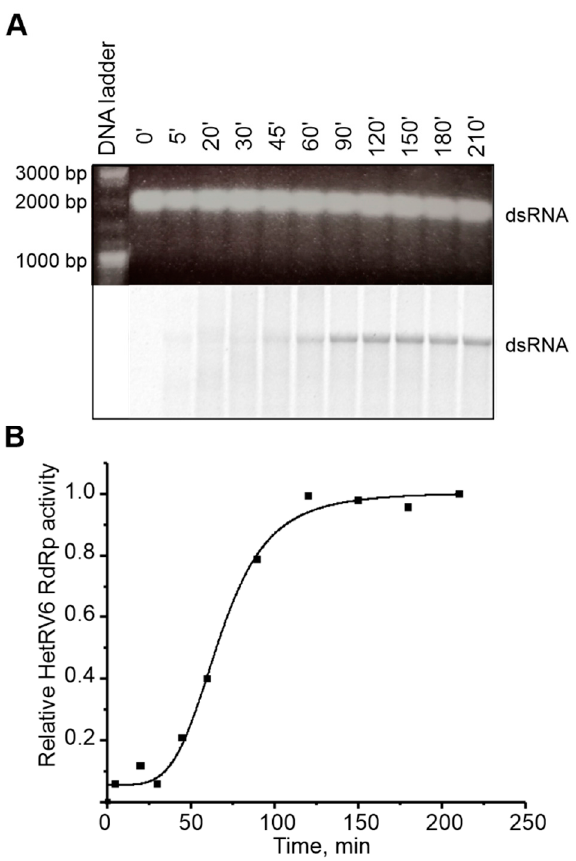
Figure 8. Transcription activity of HetRV6 RdRp. ( A ) HetRV6 dsRNA1 was used as a template in the polymerase reaction. A 10 µL aliquot was removed from the reaction at the indicated time point. The native agarose gel is presented at the top. A corresponding autoradiogram shows label incorporation from [ α - 33 P]-UTP (below). ( B ) Time course of the transcription activity on the viral HetRV6 dsRNA1. The intensity of the labeled product in ( A ) was measured using Fiji software, and the data were normalized so that the value 1.0 was attributed to the highest value of intensity.